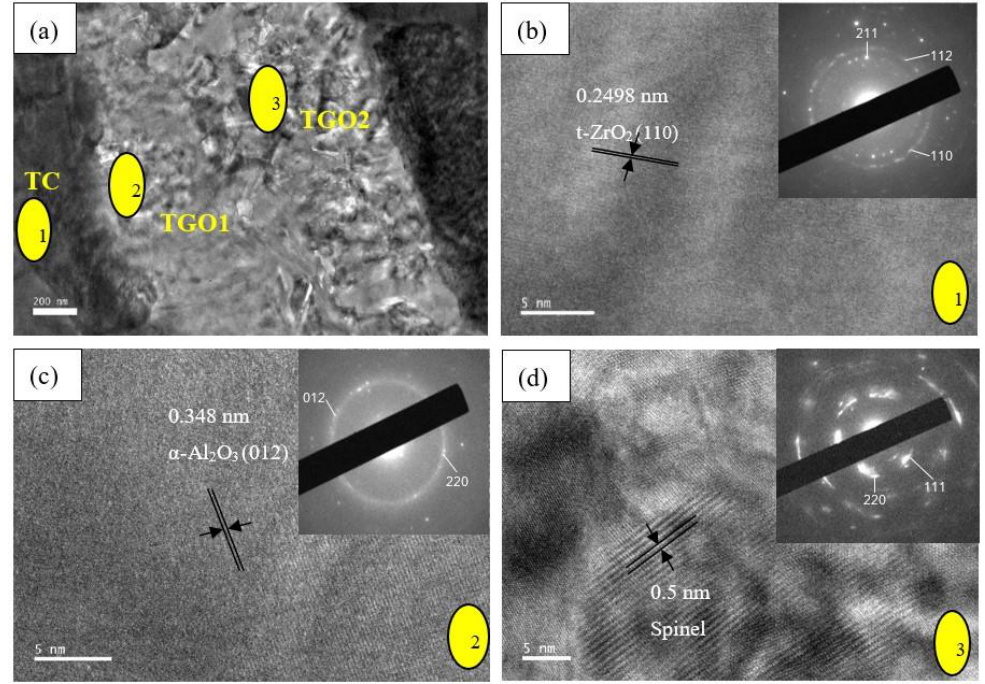
Figure 10 . TEM micrograph of ( a ) TGO cross-sectional of sample A100h with interplanar distance and diffraction patterns at ( b ) topcoat, ( c ) TGO1, and ( d ) TGO2.